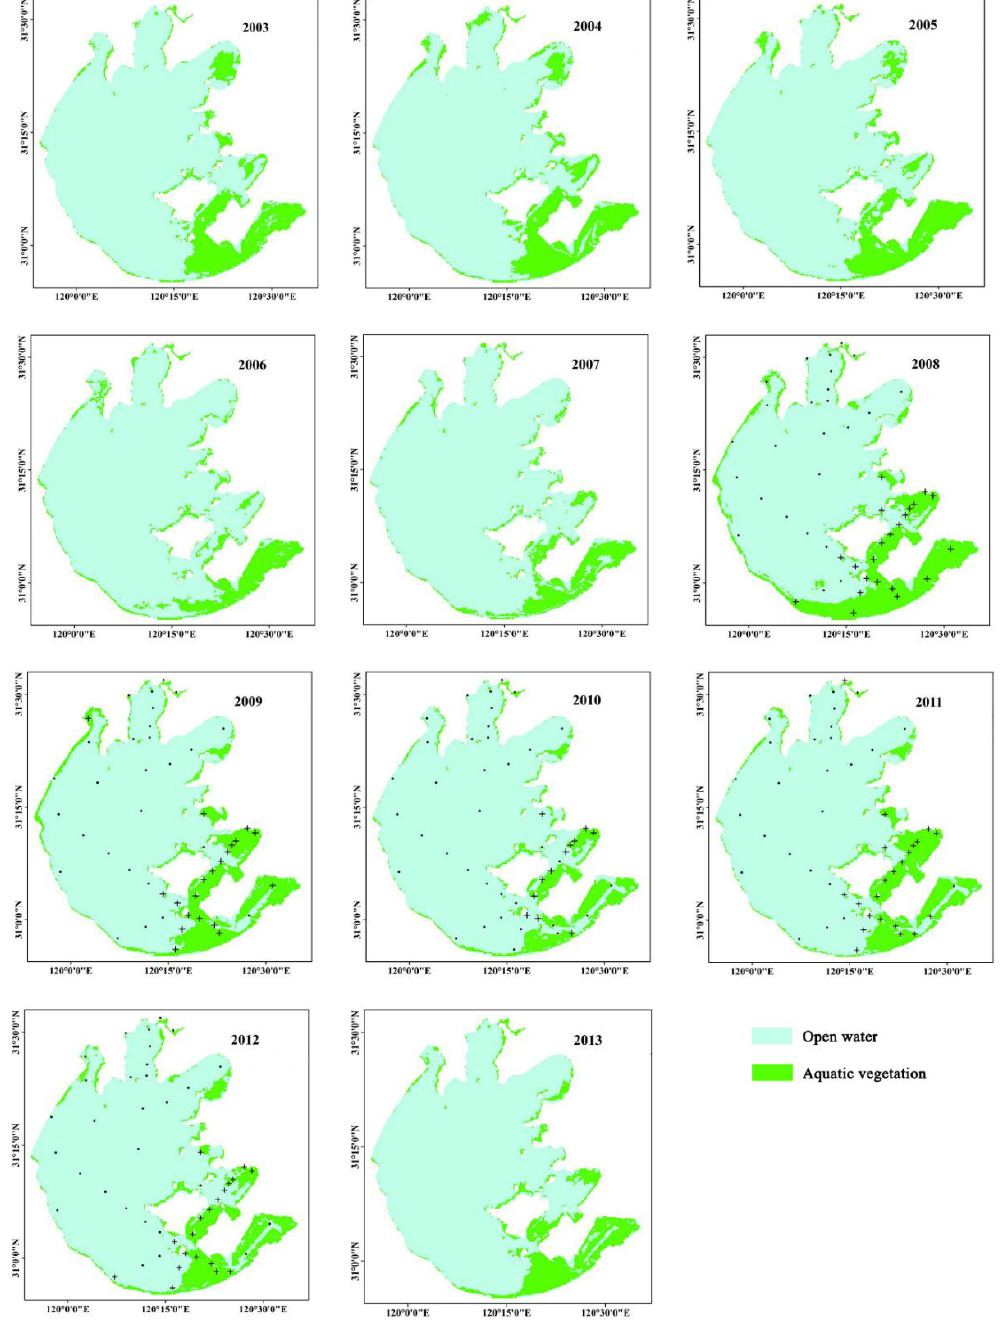
Figure 7. Distribution of aquatic vegetation from 2003–2013 and the distribution based on ground-truth measurements from 2008–2012. The presence of aquatic vegetation at the locations is denoted by black crosses and the absence of aquatic vegetation is denoted by black